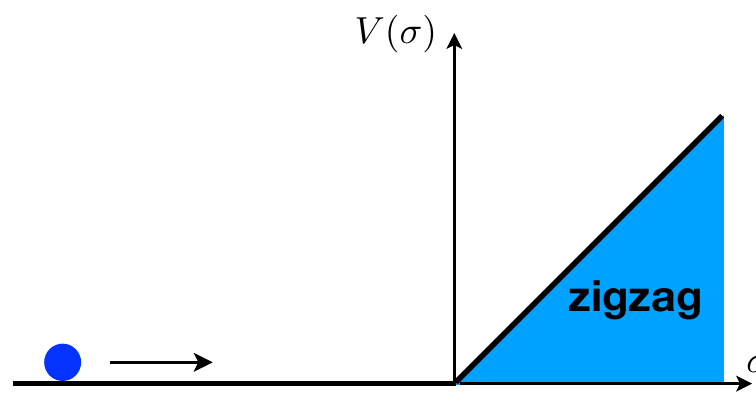
Figure 5 . Potential describing a two-particle collision in the